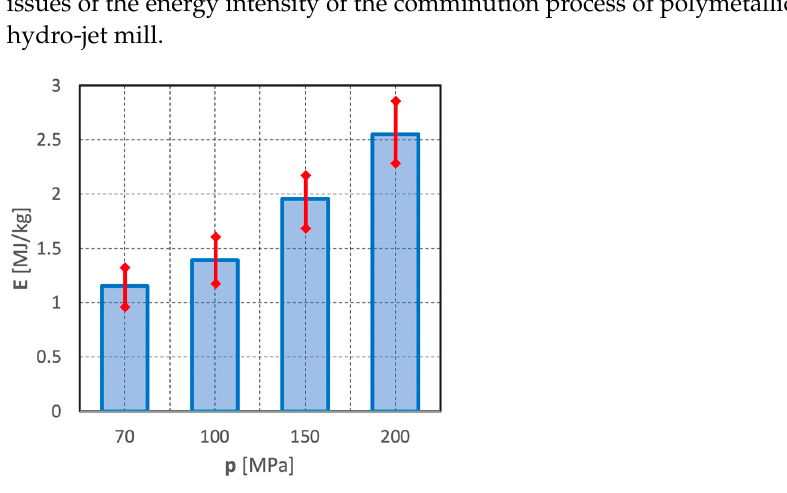
Figure 19. Effect of water jet pressure on the unit energy expenditure of polymetallic concretions comminution in a hydro-jet mill (for d w = 0.7 mm, d h = 2.4 mm, s = 10 mm).